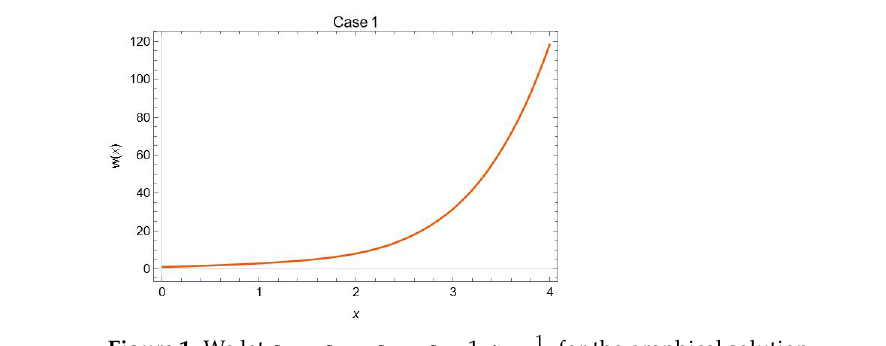
, for the graphical 2